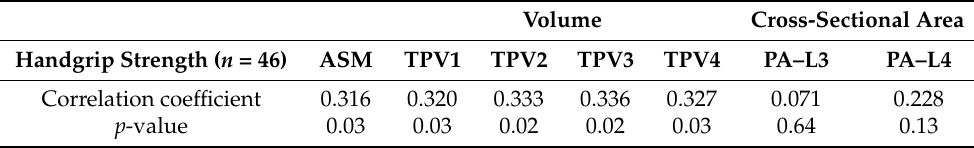
Table 3. Pearson correlation test between psoas muscle volume, cross-sectional area, ASM, and handgrip